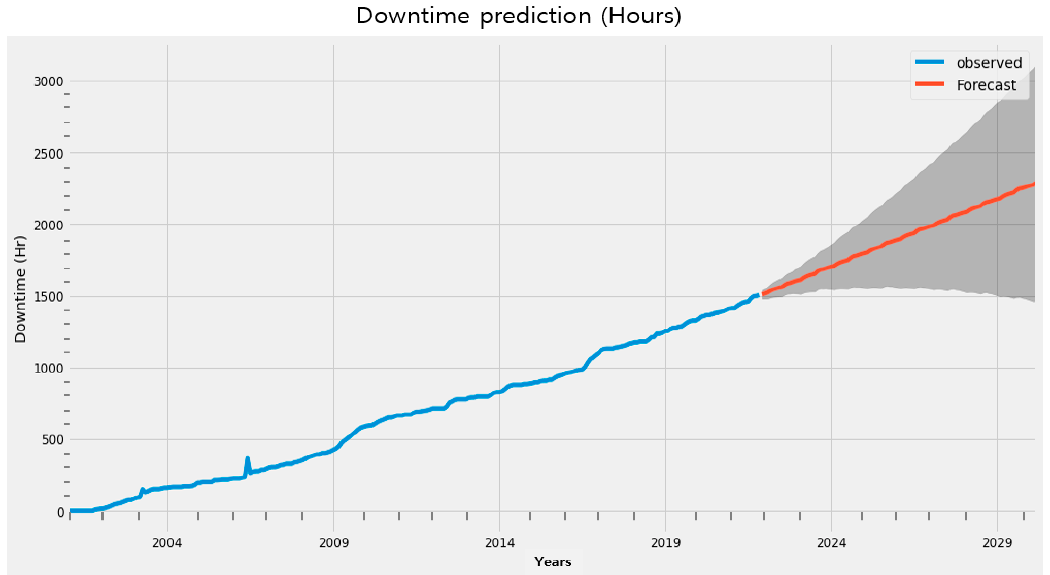
Figure 5. Downtime prediction with the ARIMA model (mean square error = 0.25, represented by dark gray bands).